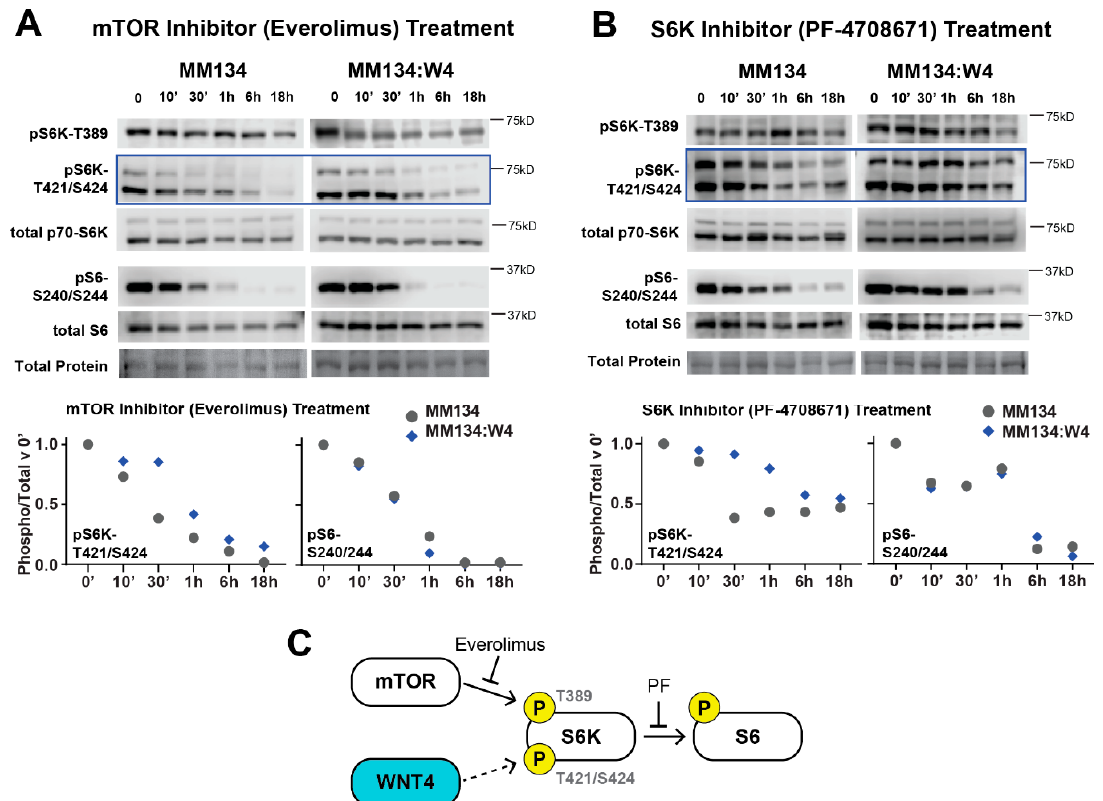
Figure 3. WNT4 regulates S6K phosphorylation at T421/S424. (A–B), Parental MM134 cells or WNT4-overexpressing cells (MM134:W4) in full serum were treated with 10nM everolimus ( A ) or 30 μ M PF-4708671 ( B ) for increasing time as indicated. Blue boxes highlight time-dependent shifts in kinase inhibitor response driven by WNT4 over-expression (discussed in text). pS6K-T421/S424 and pS6 levels are quantified at bottom (normalized to total S6K or S6, respectively); data are representative of 2–3 replicate experiments. Total protein detected with Ponceau staining. ( C ) WNT4 regulates phosphorylation of S6K at T421/S424, and as such required for S6K activity, but S6K activity remains dependent upon upstream activation by mTOR (T389).